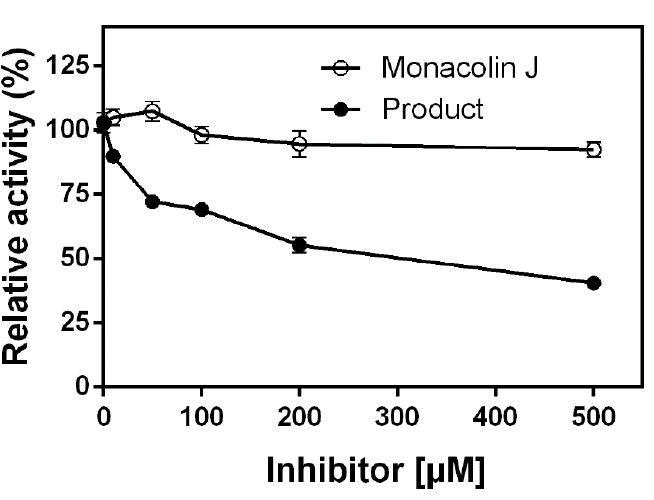
Figure 9. Inhibitory effects of monacolin J and its product on HMG-CoA reductase. The inhibitory activity of monacolin J and its product (6 ′ a-hydroxymethyl monacolin J) on HMG-CoA reductase was determined. Monacolin J and its product were used at concentrations up to 500 μ M. Data are shown as the means ( n = 3) ± SEM.